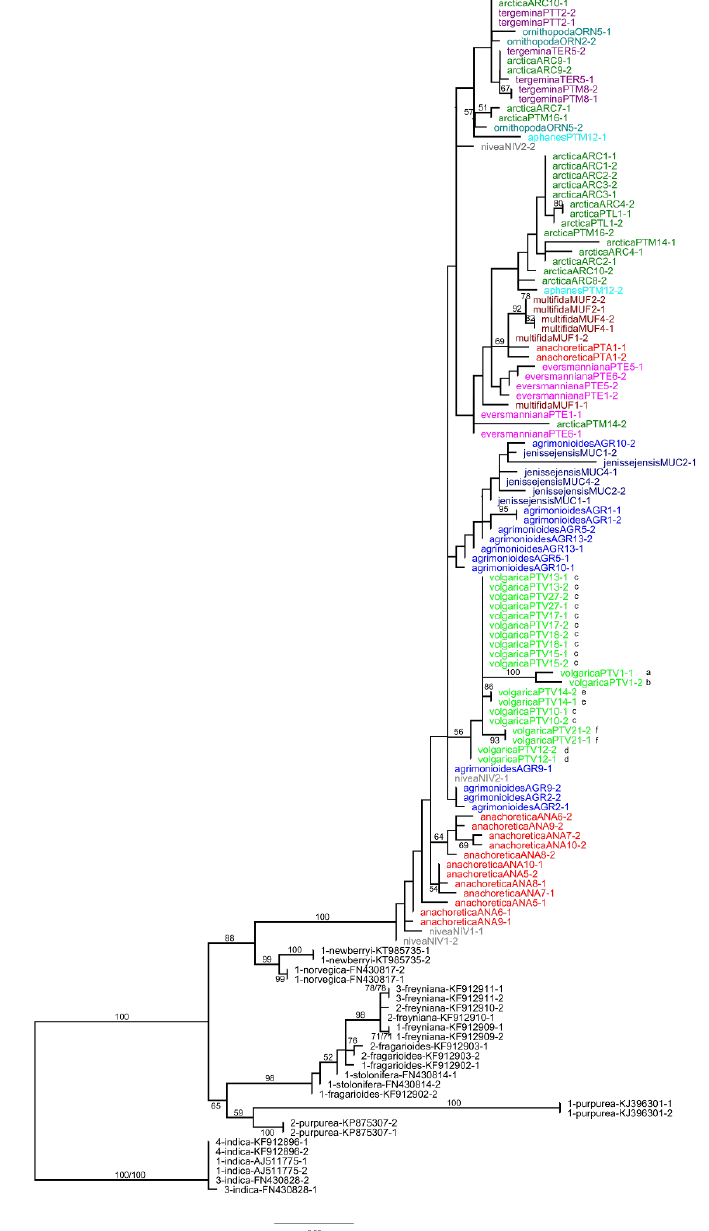
Figure A1. Maximum likelihood tree of Potentilla multifida agg. based on ITS data. Terminal names within the ingroup are followed by accession designations as in Table A1 and Figures 1 or 2 indicating reconstructed alleles. Lower-case letters after P. volgarica terminals indicate ribotypes of this species. Different species are highlighted with different colors.